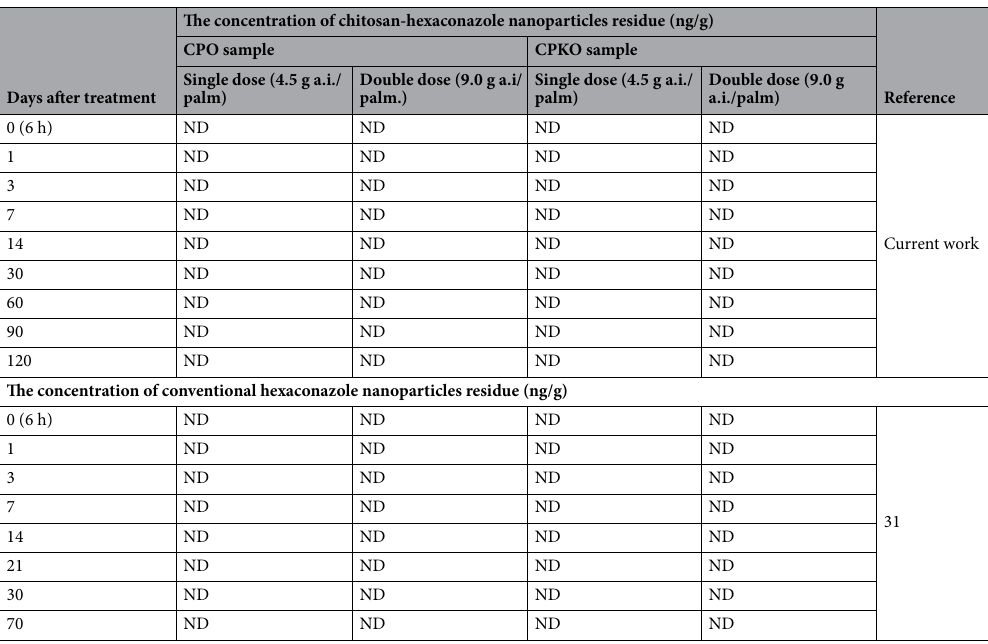
Table 3. The accumulation of chitosan-hexaconazole nanoparticles and conventional hexaconazole residues found on the fruits of oil palms. ND not detected.